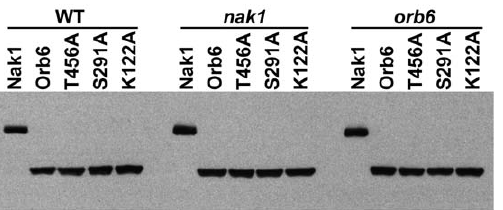
Figure 1. Expression of Nak1 and Orb6 mutants. HA-Nak1, HA- Orb6, HA-Orb6 T456A , HA-Orb6 S291A , and HA-Orb6 K122A were expressed in WT (SP199), nak1 and orb6 ts cells using plasmids derived from pREP3X containing the thiamine repressible nmt1 promoter (Materials and Methods). HA-tagged proteins were detected by Western blots using anti-HA (12CA5) monoclonal antibody.